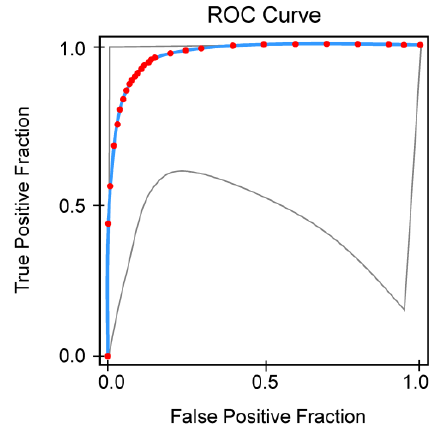
Figure 6. Receiver operating characteristics (ROC) analysis of MCI-to-dementia conversion (MDC) prediction at 6-month follow-up based on the lack of BA5-BA8 theta and alpha connectivity changes after iTBS application. Red symbols and blue line indicate fitted ROC curve, gray lines the 95% confidence interval of the fitted ROC curve.